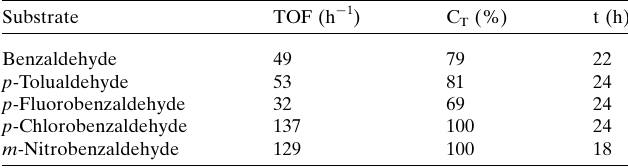
Table 4 Knoevenagel condensation over catalyst 2 .